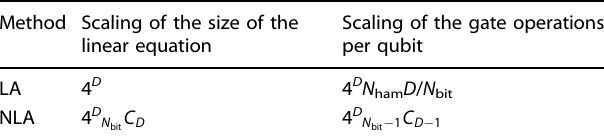
Table 1. Scaling of the size of the matrix S ( n ) and the number of gate operations per qubit of the linear equation of LA and NLA per imaginary-time step. Method Scaling of the size of the linear